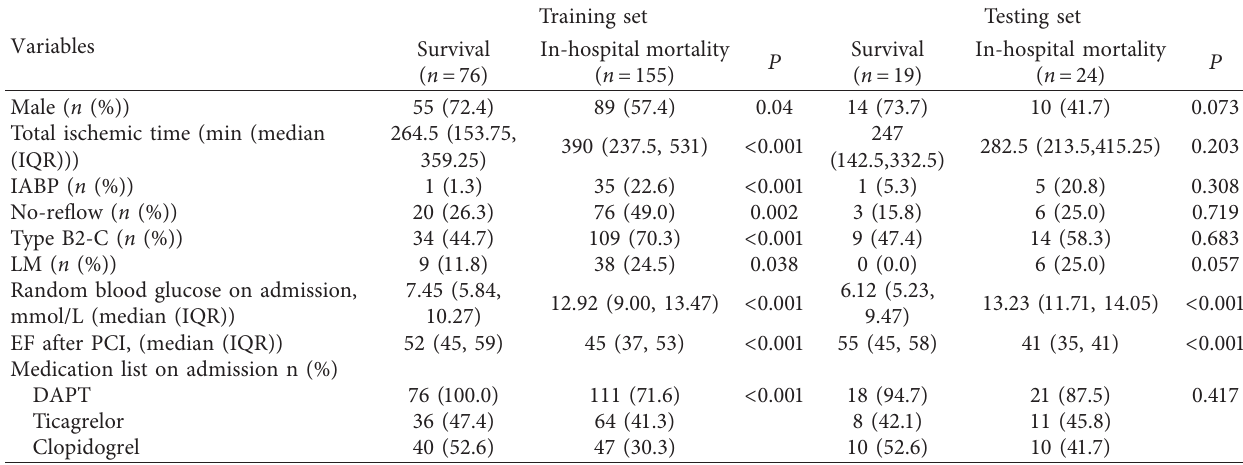
Table 1: Clinical characteristics selected as predictors for the nomogram.